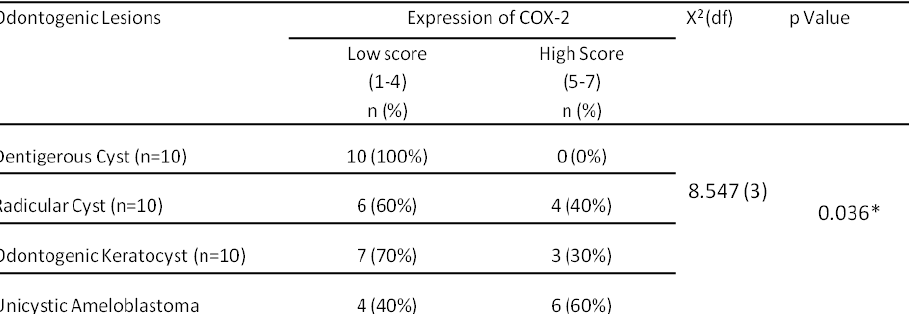
Table 4. Association of the expression of COX-2 (Total Score) among the different odontogenic Lesions